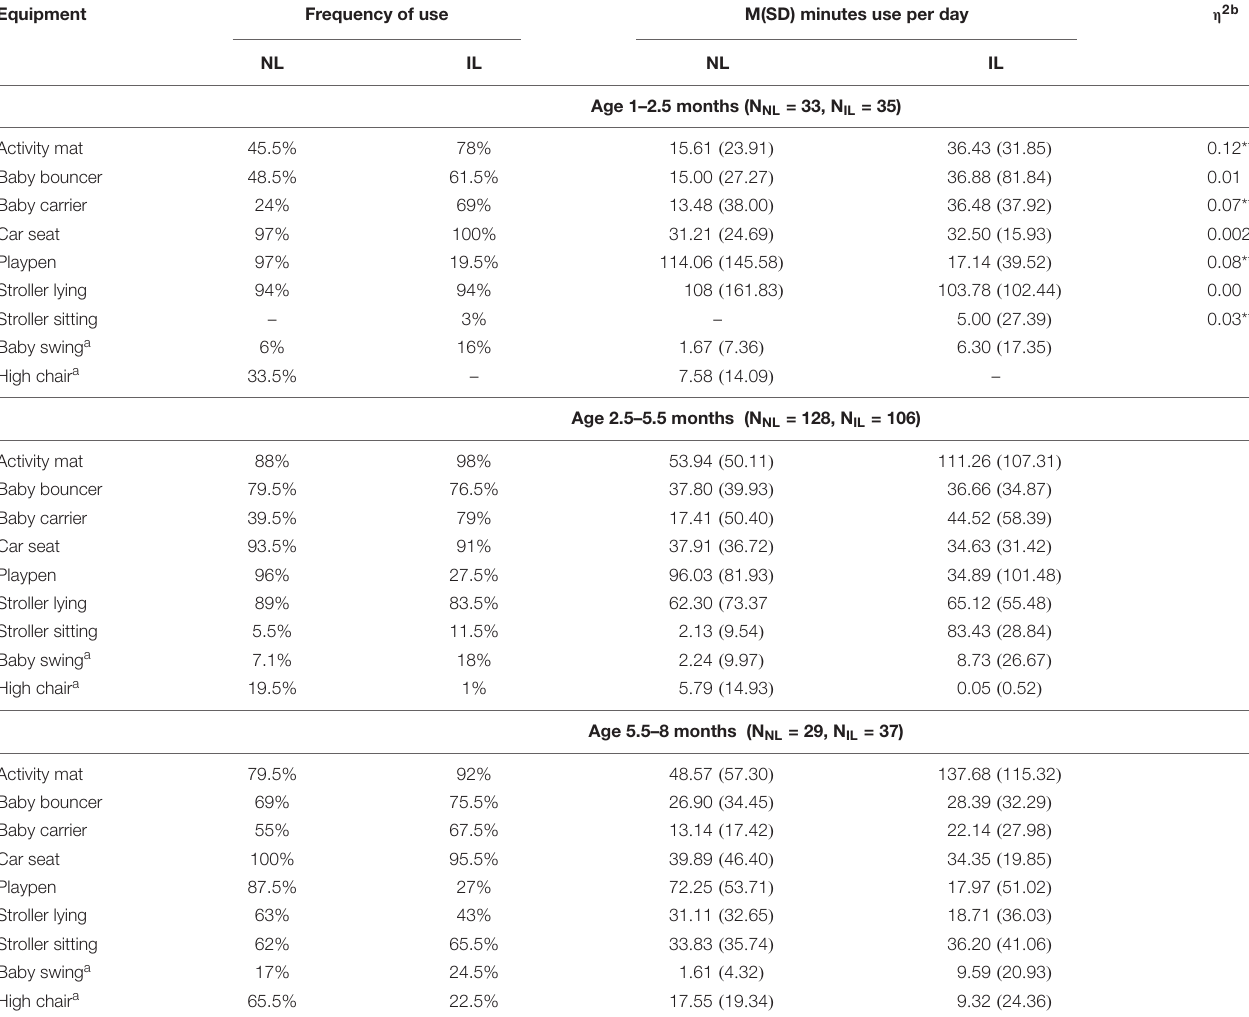
TABLE 3 | Mean time of equipment use.